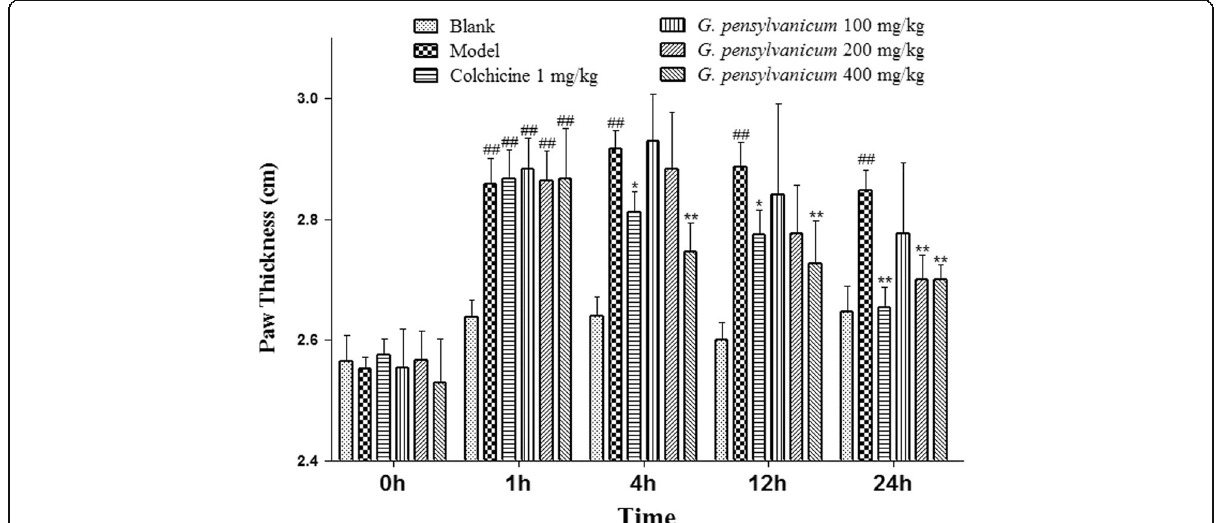
Fig. 5 Effect of G. pensylvanicum and colchicine on MSU crystal-induced paw edema in mice. Data are expressed as mean ± SEM ( n = 10). ## p < 0.01 compare with Blank group; ** p < 0.01, * p < 0.05 compare with Model group